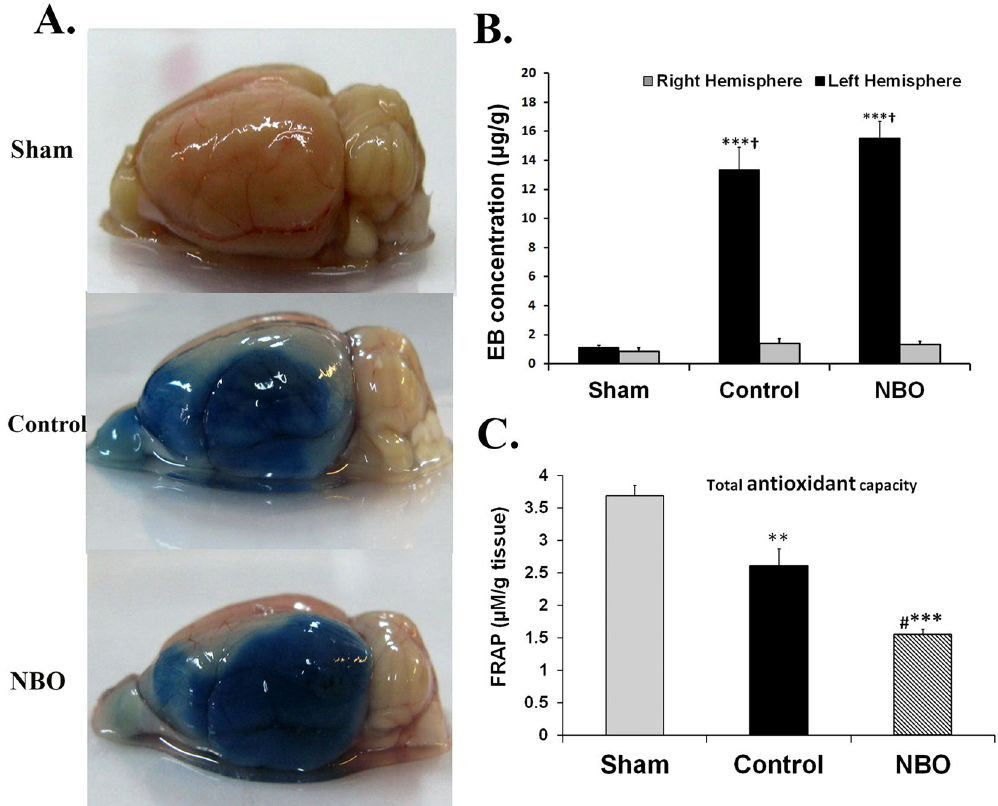
Figure 4. Effects of NBO treatment on ischemia-induced BBB destruction. ( A ) Photograph of brains in rats from studied groups 24 h after MCAO and Evans blue injection. The intensity of blue color depicted in control and NBO treated rats is related to the extent of damage to the cerebral vasculature of the lesioned side. ( B ) EB concentration in the left and right side of the brains in the studied groups (n = 6–7). ( C ) Assessment of brain tissue antioxidant power based on FRAP value in experimental groups (n = 6–9). Values are mean ± SEM. ( *** P < 0.001, ** P < 0.01 compared with sham group; # P < 0.01 compared with control group; † P < 0.001 compared with right side of the same